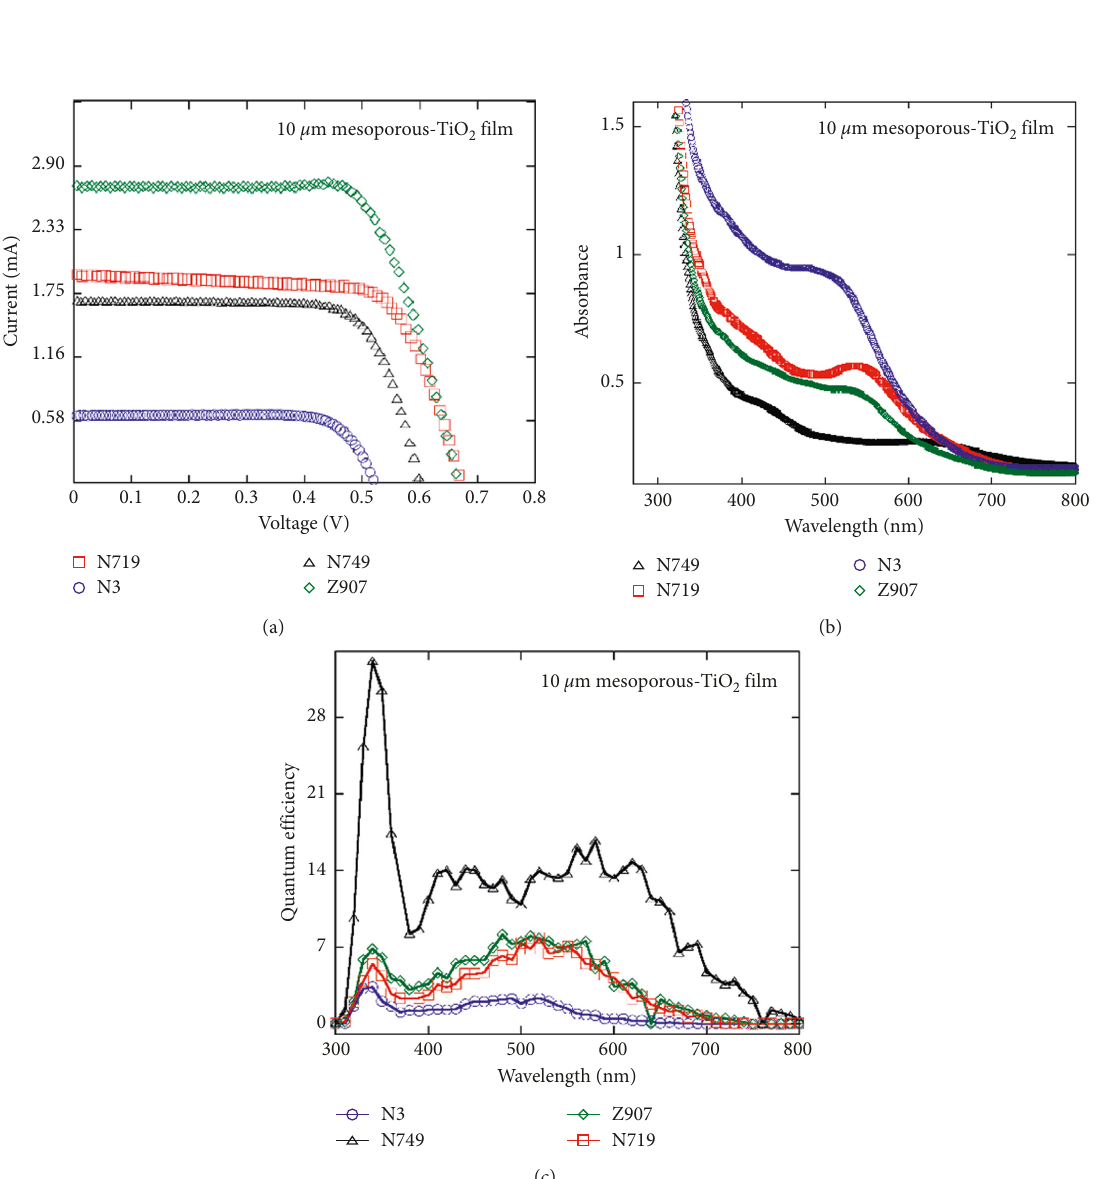
2 films using various